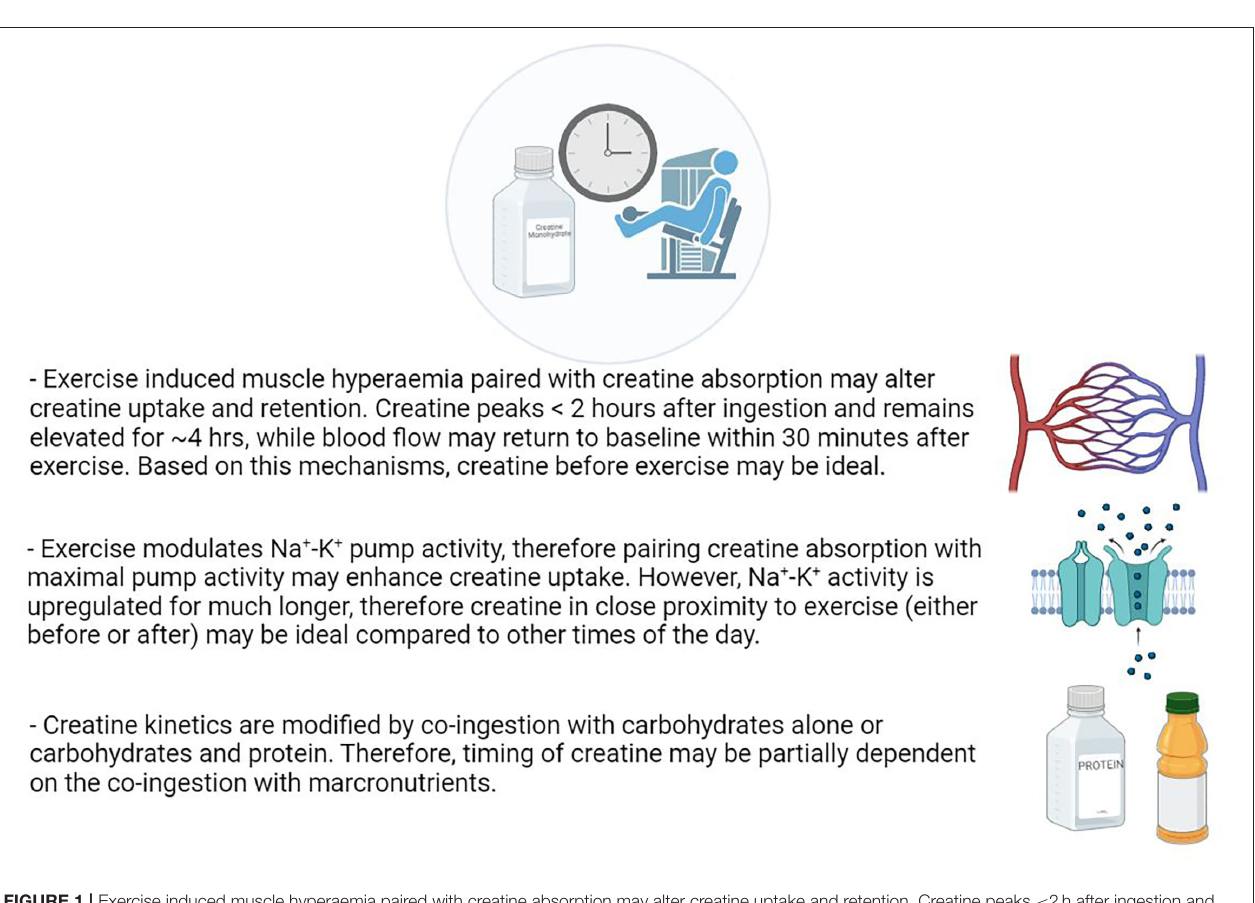
a series of studies, Green A. et al. (1996), Green A. L. et